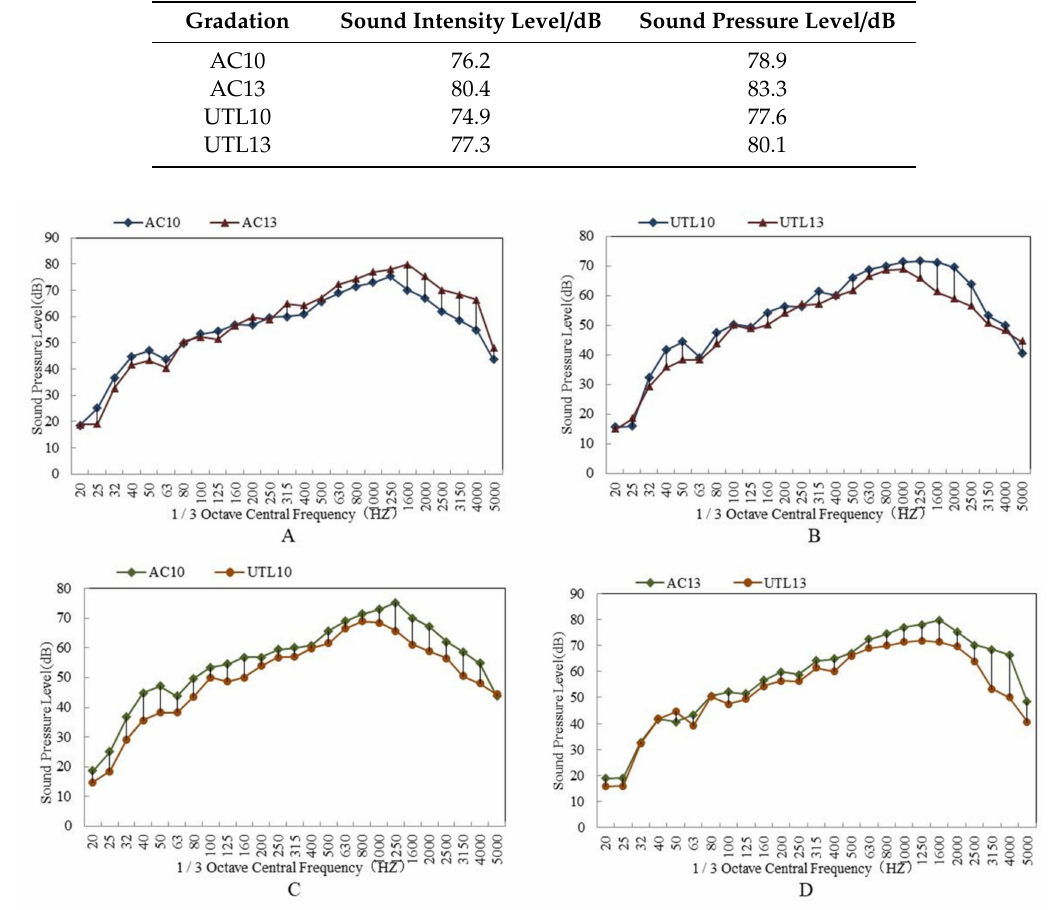
Figure 8. 1 / 3 octave band spectrum of asphalt mixture with different aggregate gradations: ( A ) Suspended dense gradation AC; ( B ) Dense framework gradation UTL; ( C ) 9.5 mm NMAS; (D) 13.2 mm